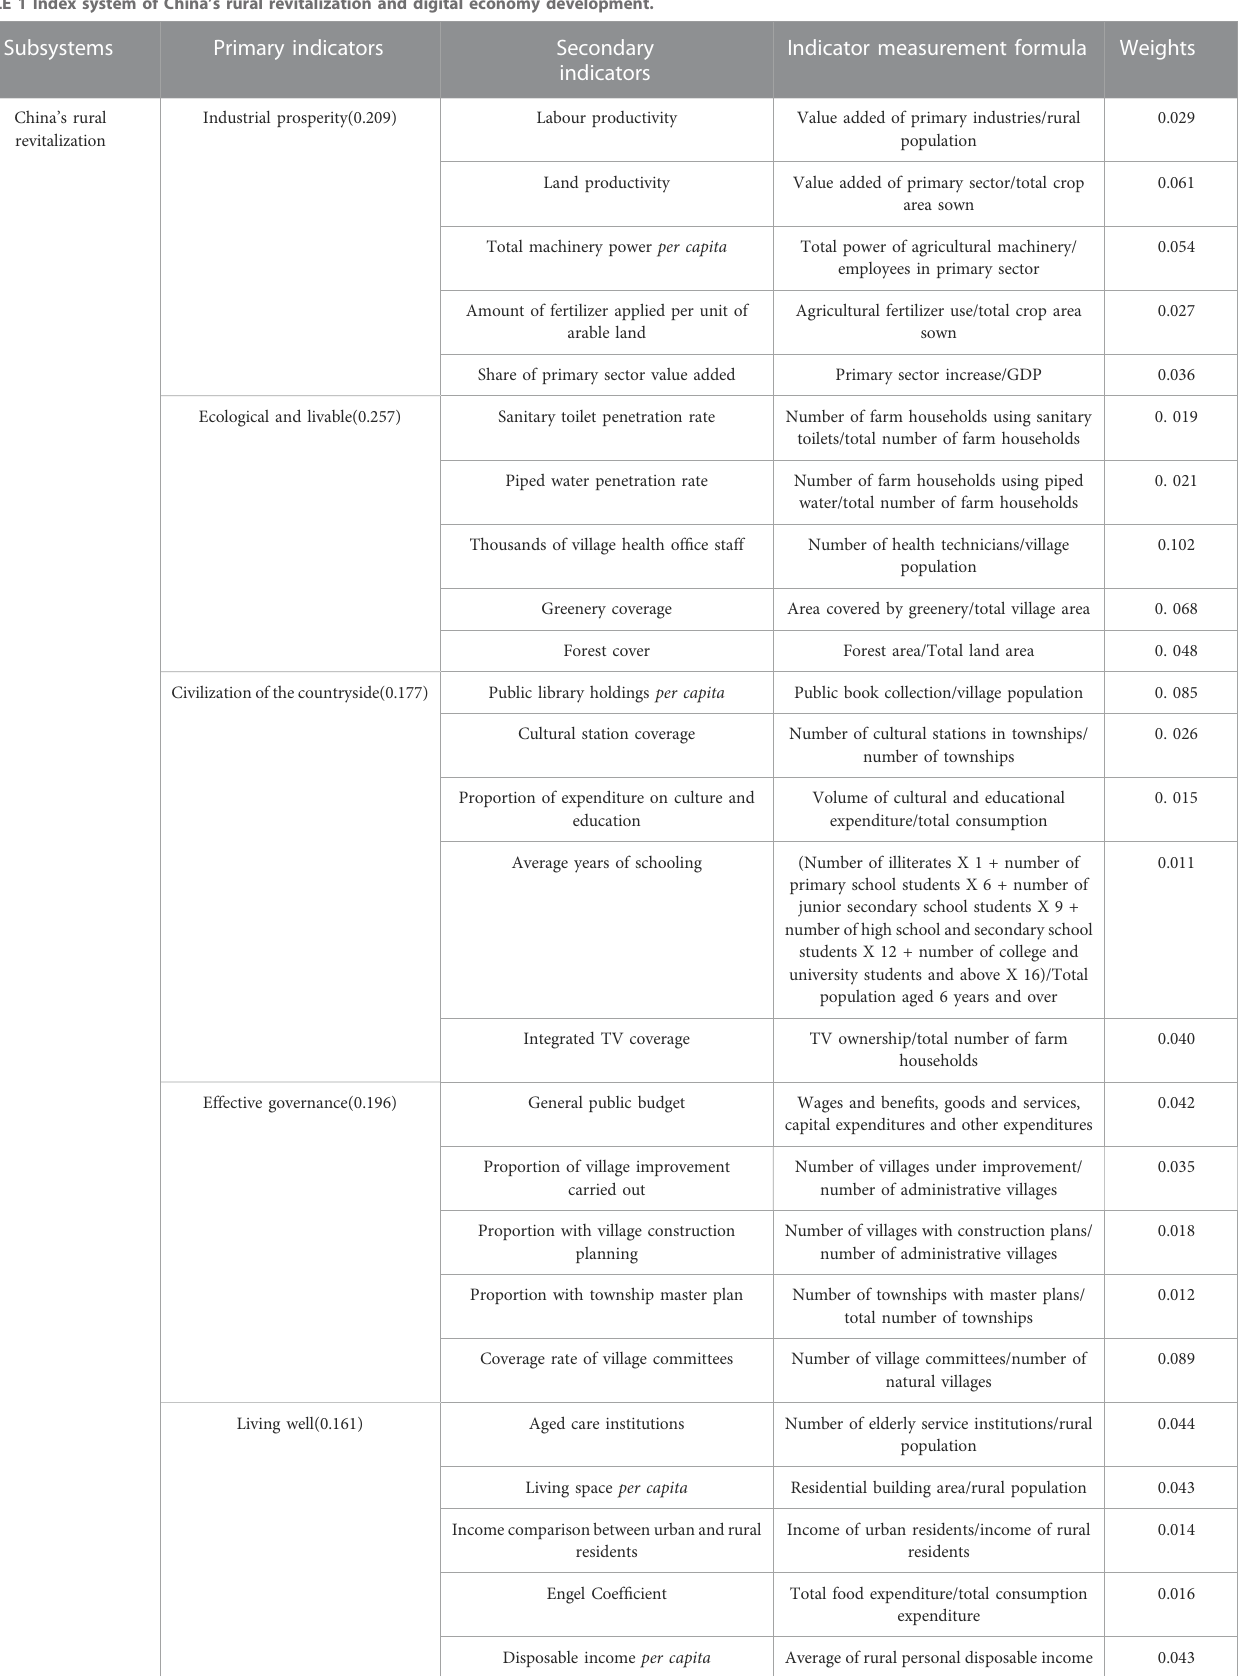
TABLE 1 Index system of China ’ s rural revitalization and digital economy